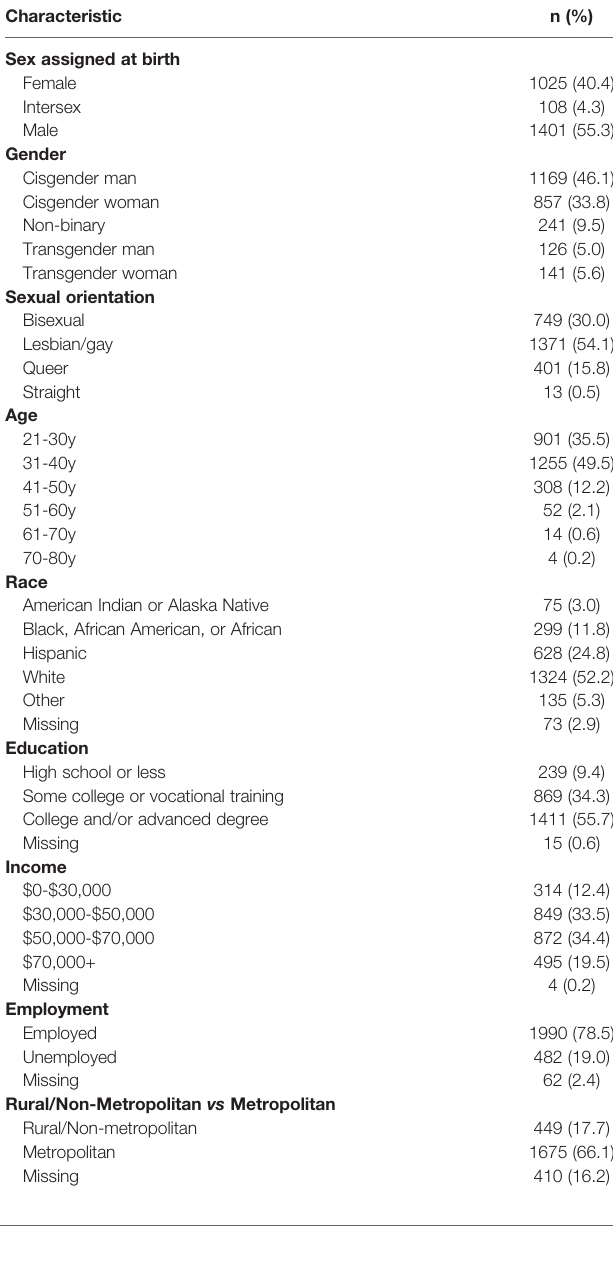
TABLE 3 | Demographic characteristics of the population